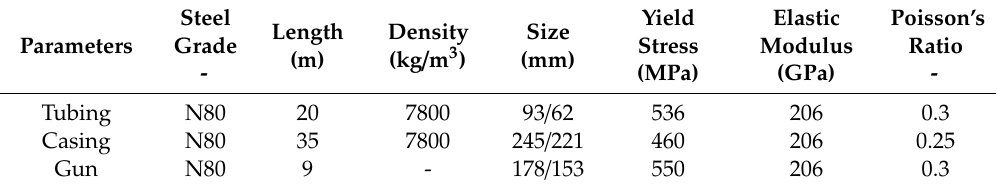
Table 4. Parameters of perforated string.